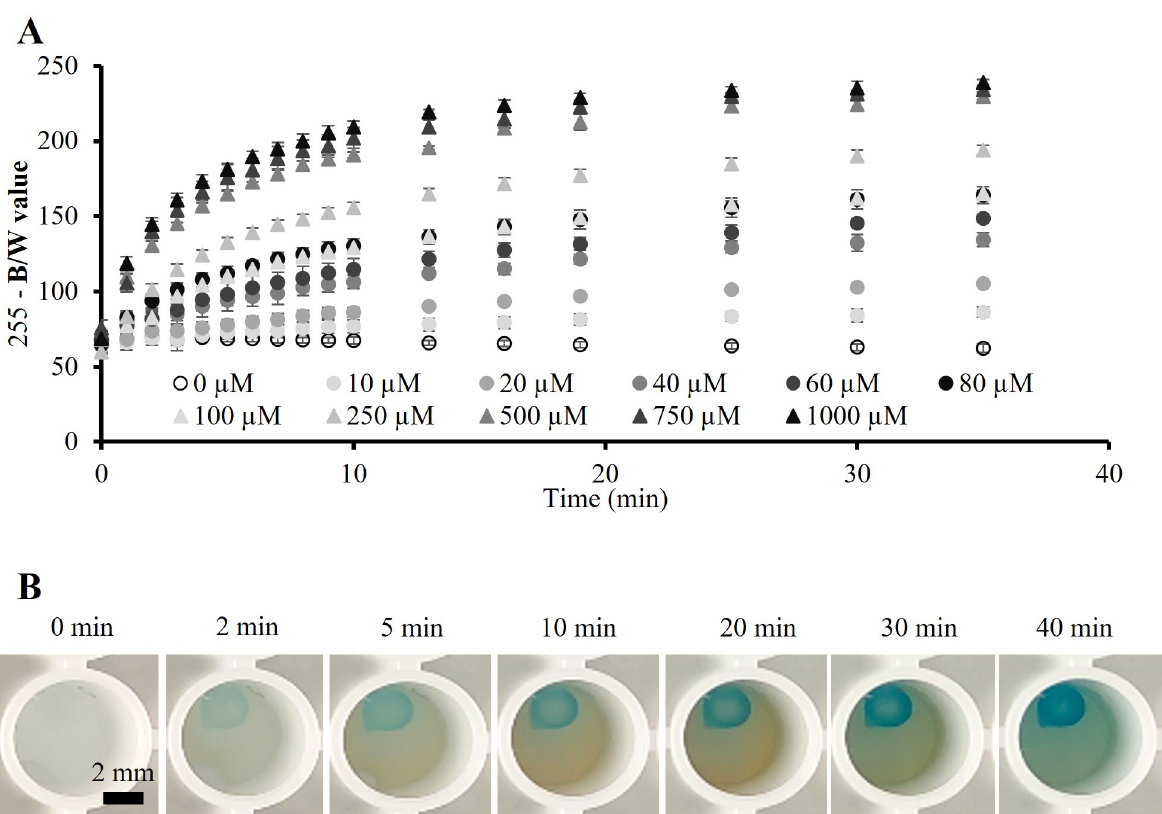
Figure 2. B/W analysis of the alginate beads for glucose sensing. ( A ) B/W values for glucose 10–1000 μ M in the alginate biosystem for 40 min (n = 4). ( B ) Real images of an alginate bead biosystem in artificial sweat 80 μ M glucose solution, over time.